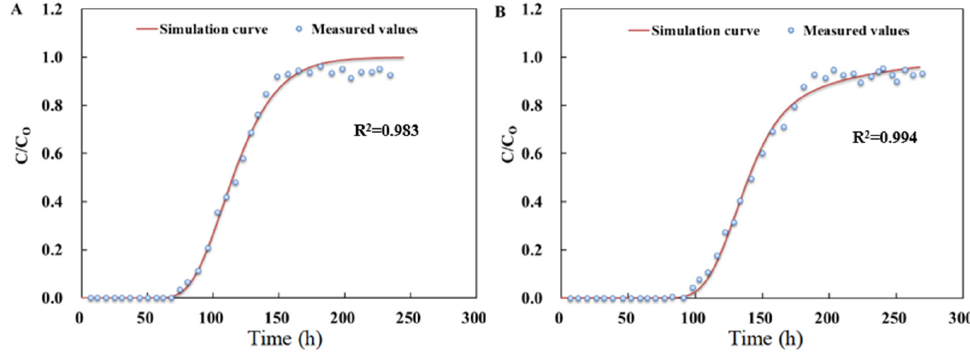
Figure 5. The penetration experimental data of SMX (( A ) column 2; ( B ) column 4).